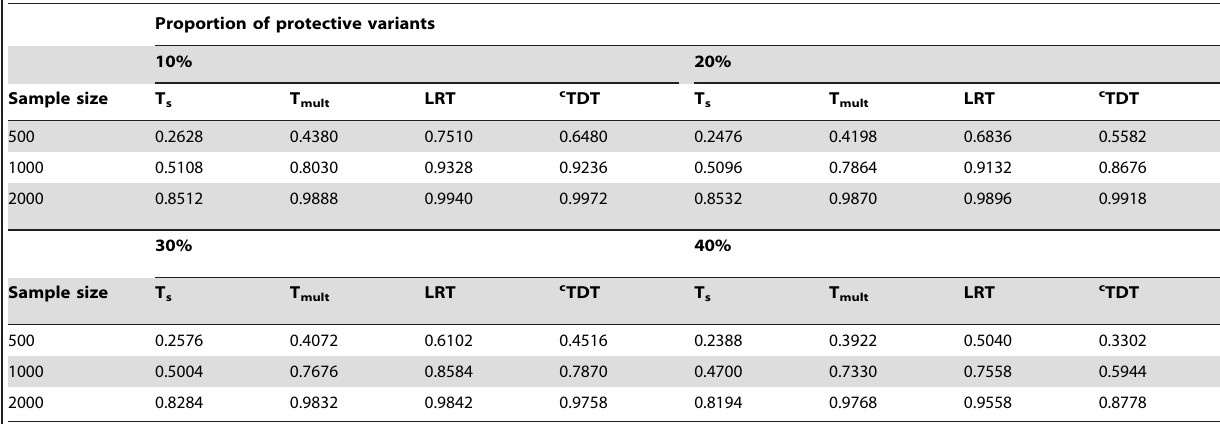
Table 3. The power of the tests when effects are in different directions a